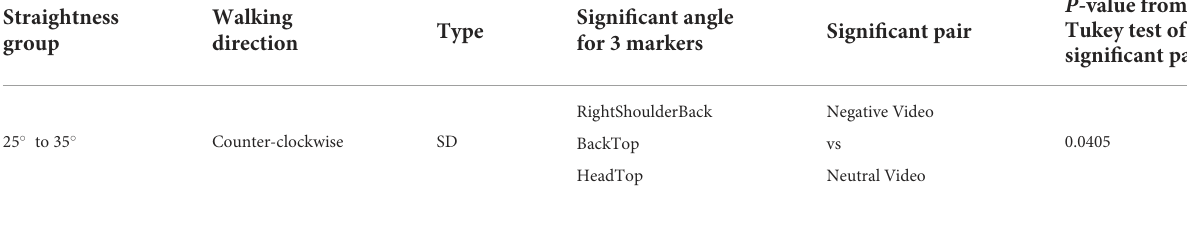
Significant angle Type for 3 markers